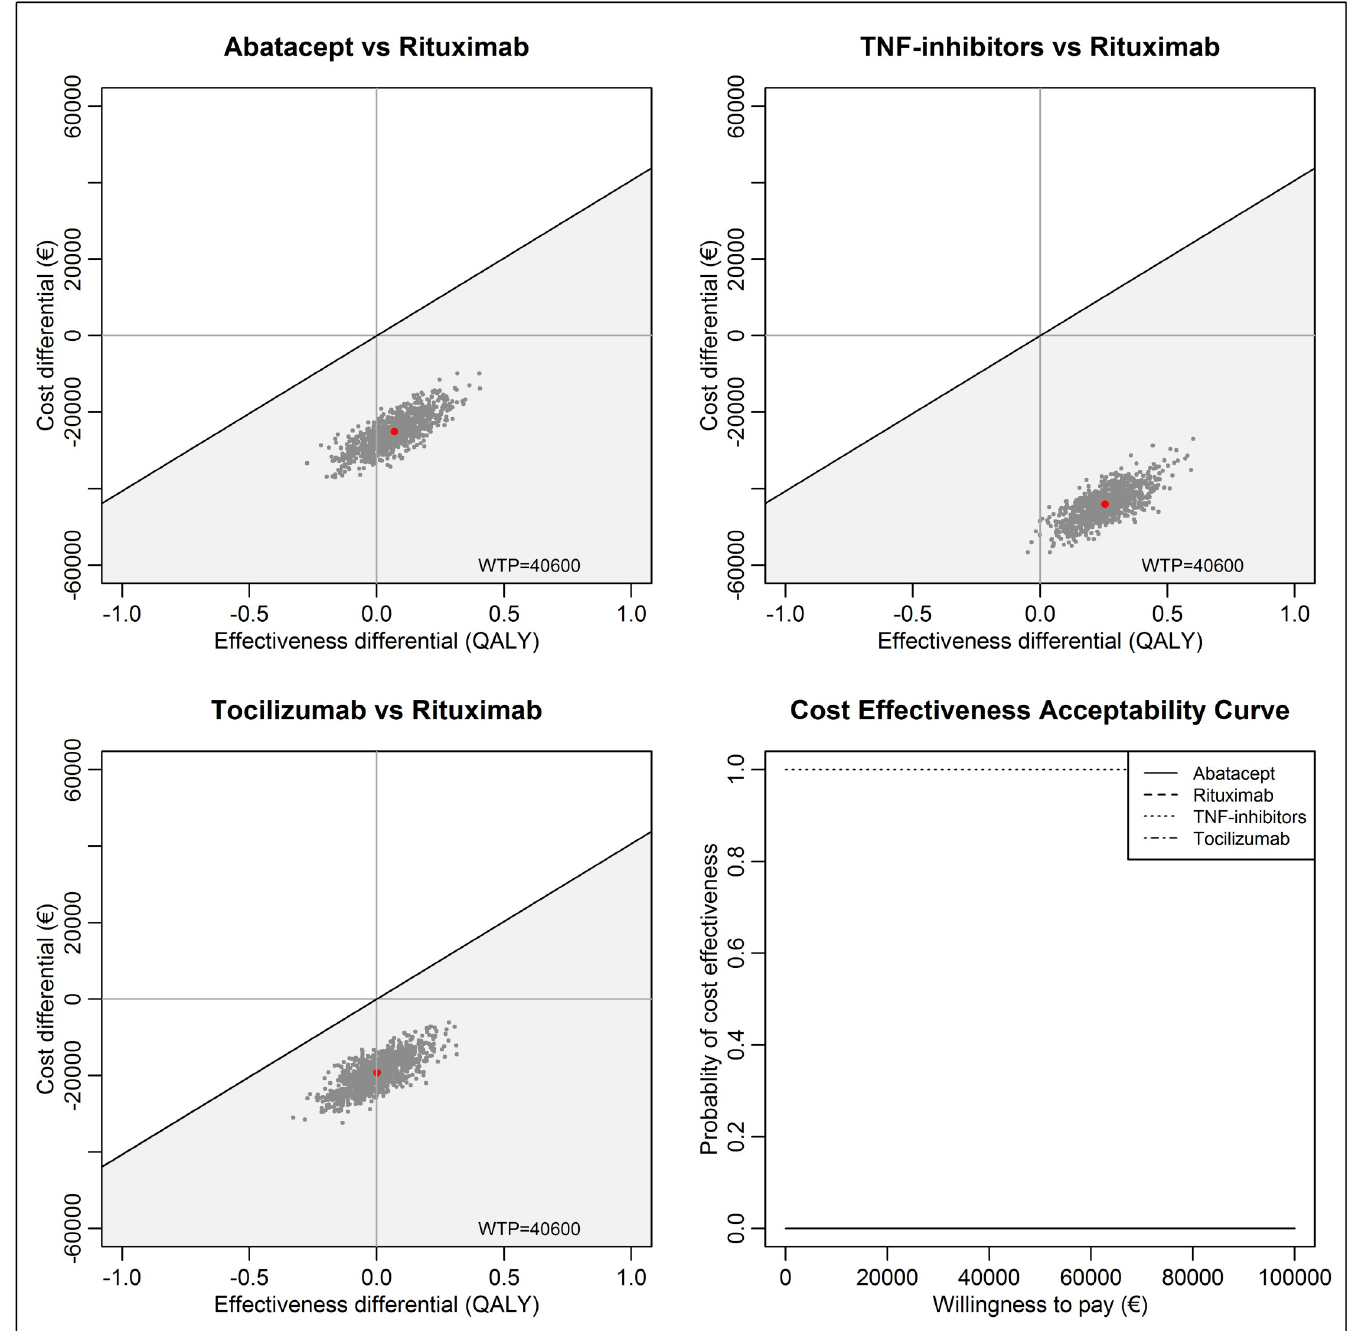
Fig 2. Incremental cost-effectiveness planes and cost-effectiveness acceptability curve for abatacept, TNF inhibitors, and tocilizumab in comparison to rituximab for the treatment of rheumatoid arthritis as a second-line therapy in a lifetime scenario. ICER = incremental cost-effectiveness ratio, QALY = quality-adjusted life year, TNF-inhibitors = tumor necrosis factor